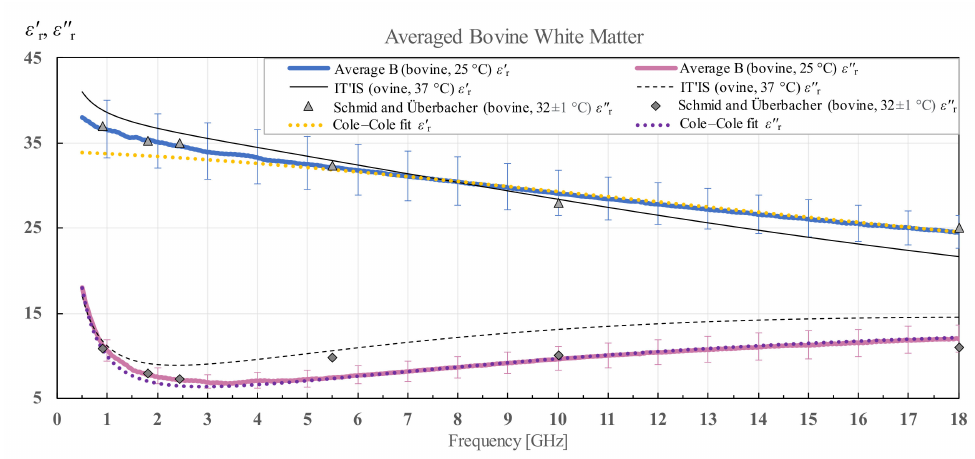
Figure 14. Average permittivity of bovine white matter with standard deviation and Cole–Cole fit, in comparison with the data from IT’IS database [21] and Schmid and Überbacher